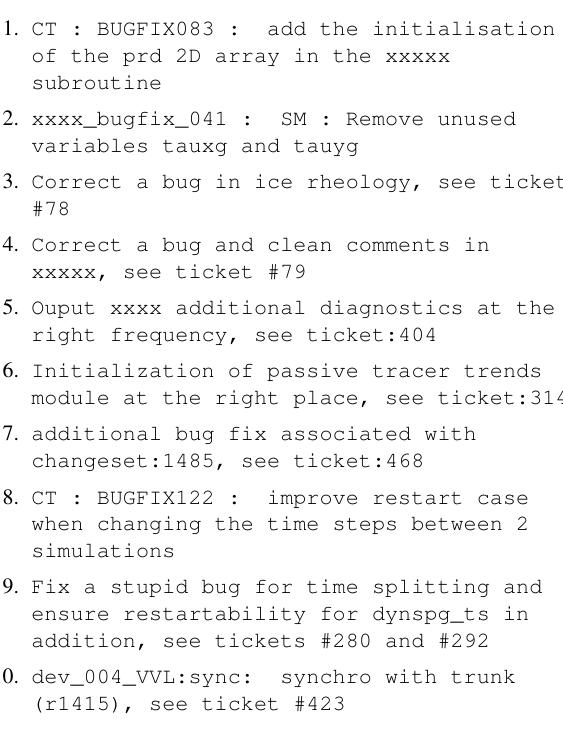
Fig. 1. A sample of version control log messages indicating a defect fix. Redacted to preserve anonymity.